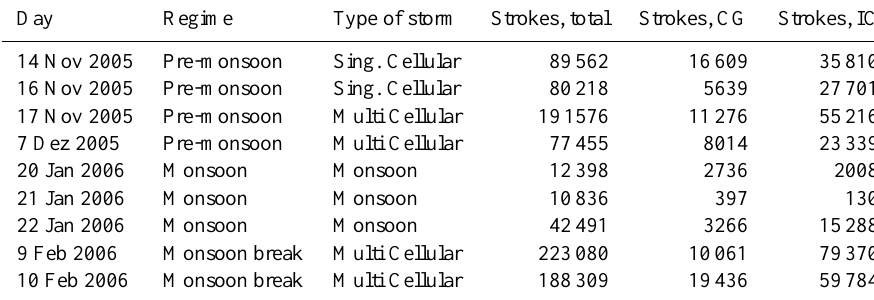
Table 3. Stroke count for selected days of the ACTIVE